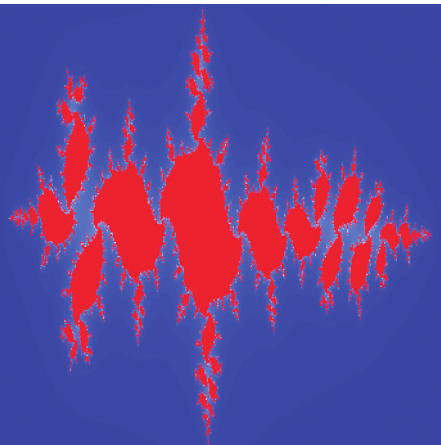
Figure 3: Quadratic Julia set in JSOmhh.